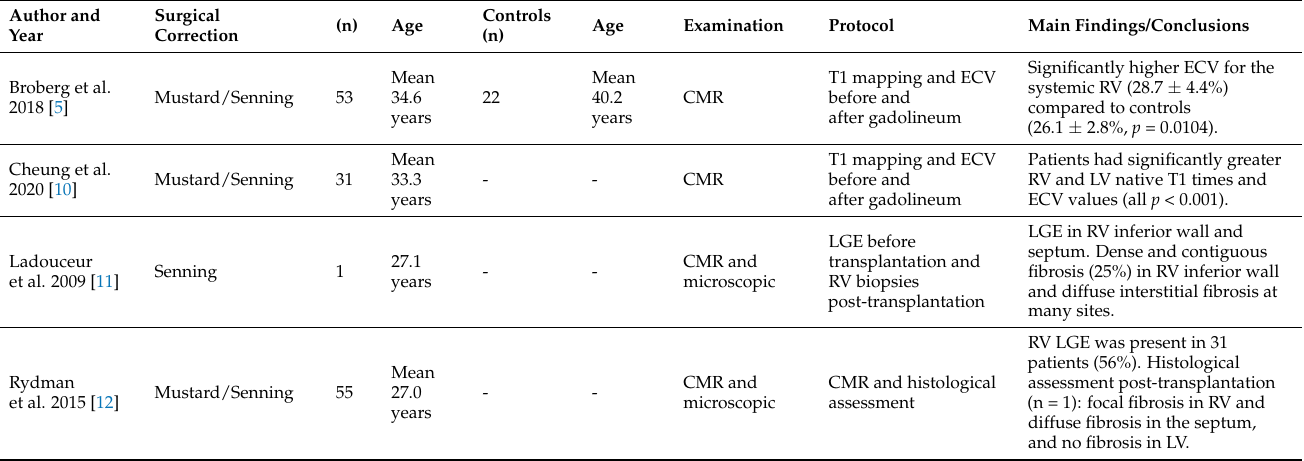
Table 3. Overview of fibrosis